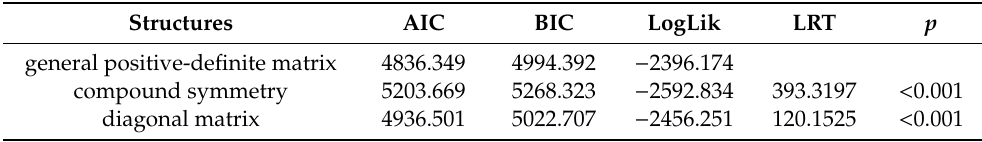
Table 3. The lack-of-fit statistics of the linear mixed-e ff ects individual-tree basal area increment model using the three random e ff ects variance–covariance structures.